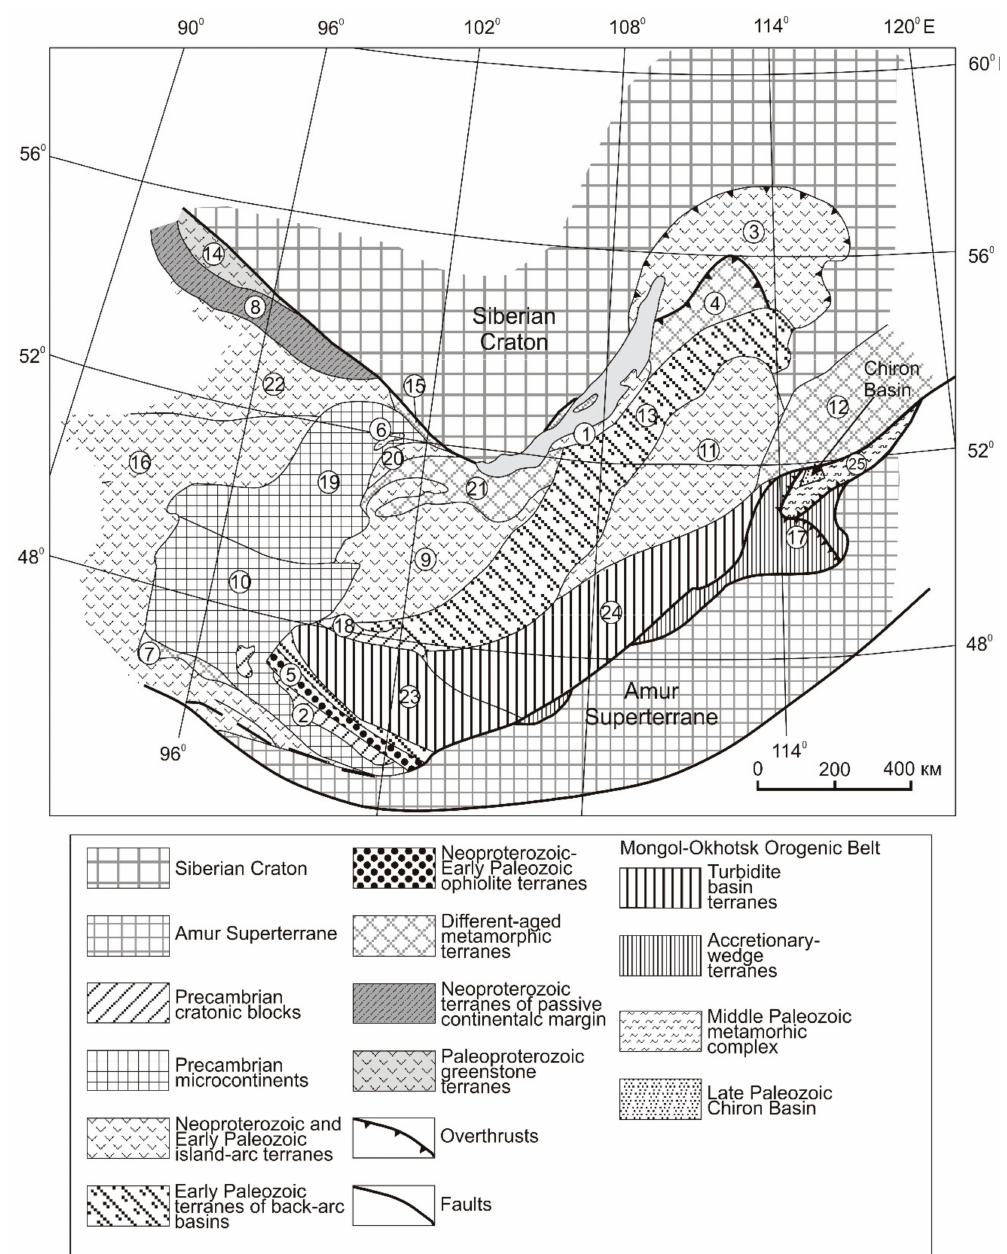
Figure 1. Tectonic scheme showing terranes in the northern segment of the Central Asian Orogenic Belt (compiled after [2,4–10]). Numbers in circles are structures (terranes, microcontinents, cratonic blocks): (1) Anga–Talanchan; (2) Baidarik; (3) Baikal–Muya; (4) Barguzin; (5) Bayan–Khongor; (6) Gargan; (7) Daribi; (8) Derbi; (9) Dzhida; (10) Dzabkhan; (11) Eravna; (12) Western Stanovoi; (13) Ikat; (14) Kan; (15) Kitoikin; (16) Ozernyi; (17) Onon; (18) Tarbagatai; (19) Tuva–Mongol; (20) Tunka;